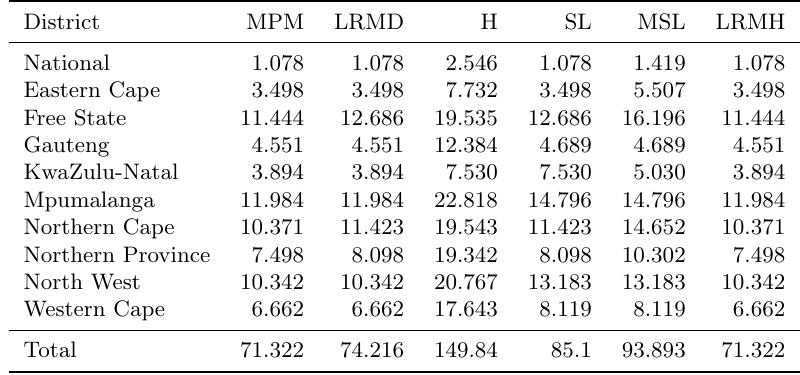
Table 6: The total absolute deviations for the allocation of seats using mathematical program- ming and the different allocation methods for the results of the South African election in 1999. The following abbreviations are used: MPM for mathematical programming models, LRMD for Largest remainder method using a Droop quota, H for d’Hondt’s method, SL for Sainte-Lagu¨e’s a Hare